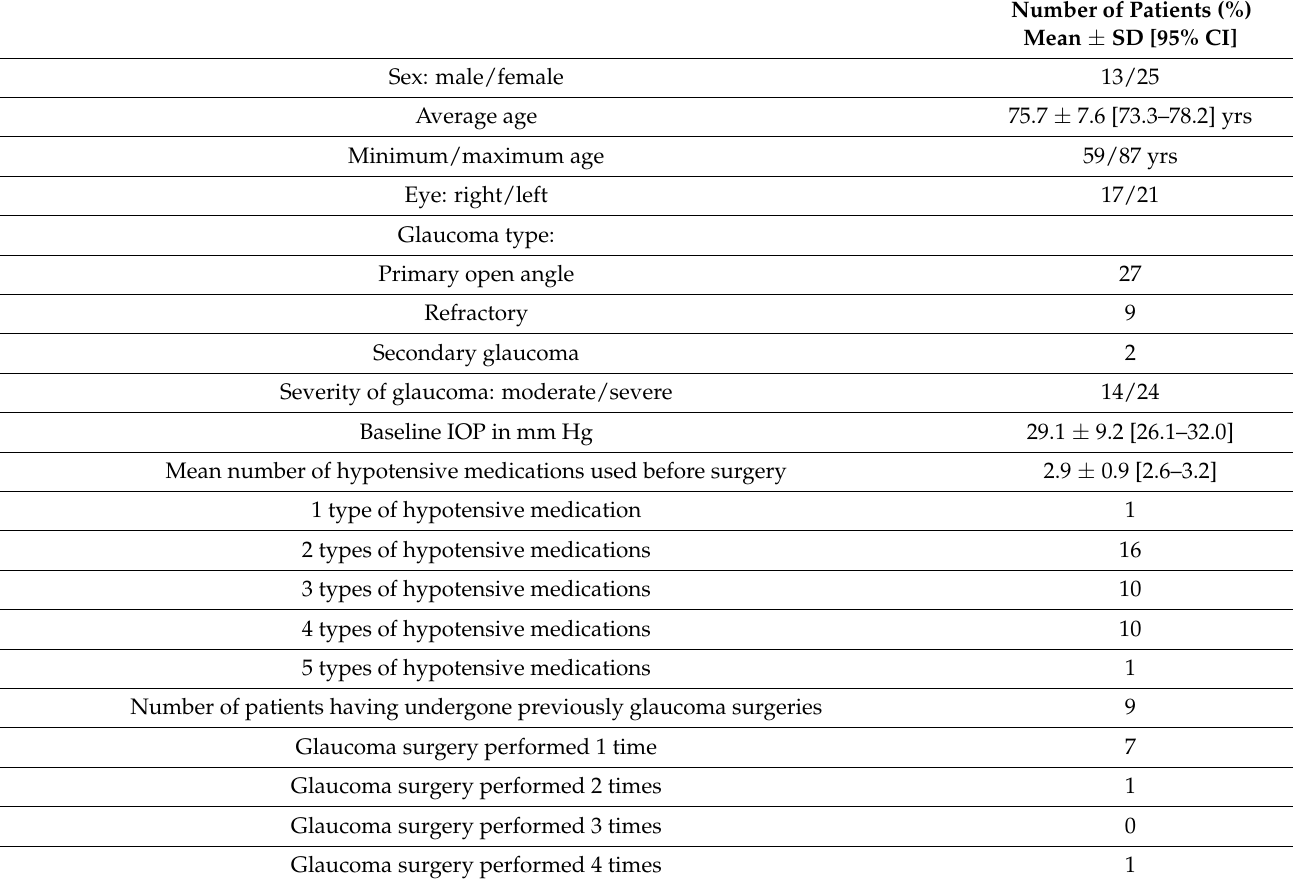
Table 1. Demographic data of patients and preoperative characteristics of the